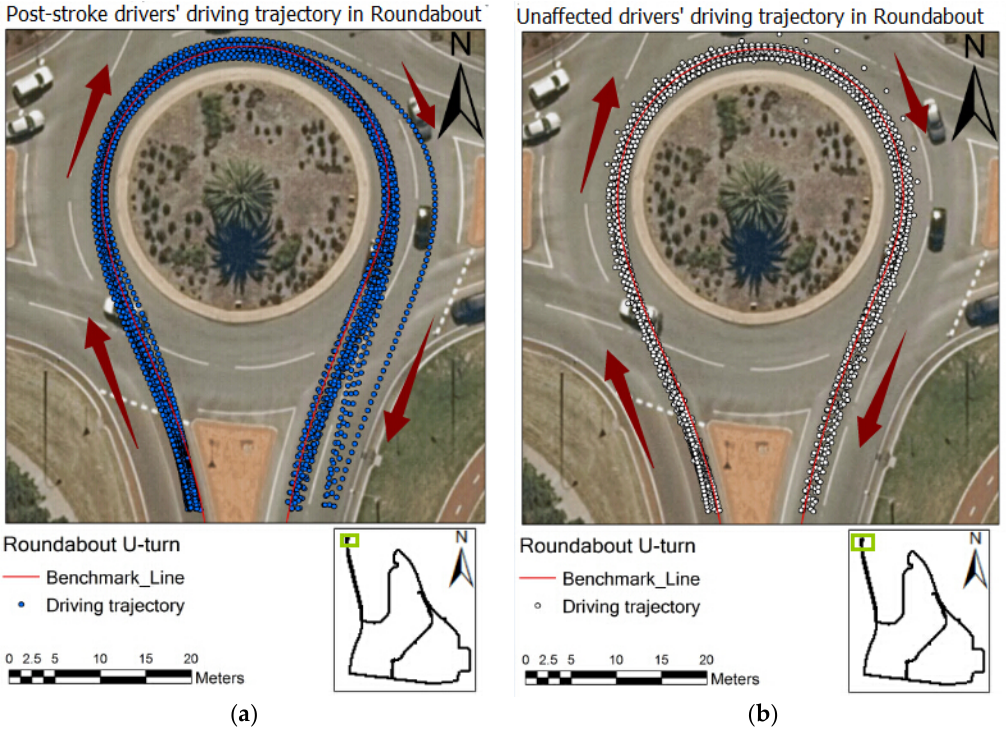
Figure 2. Driving trajectory of post-stroke ( a ) and normal ( b ) groups in a U-turn.